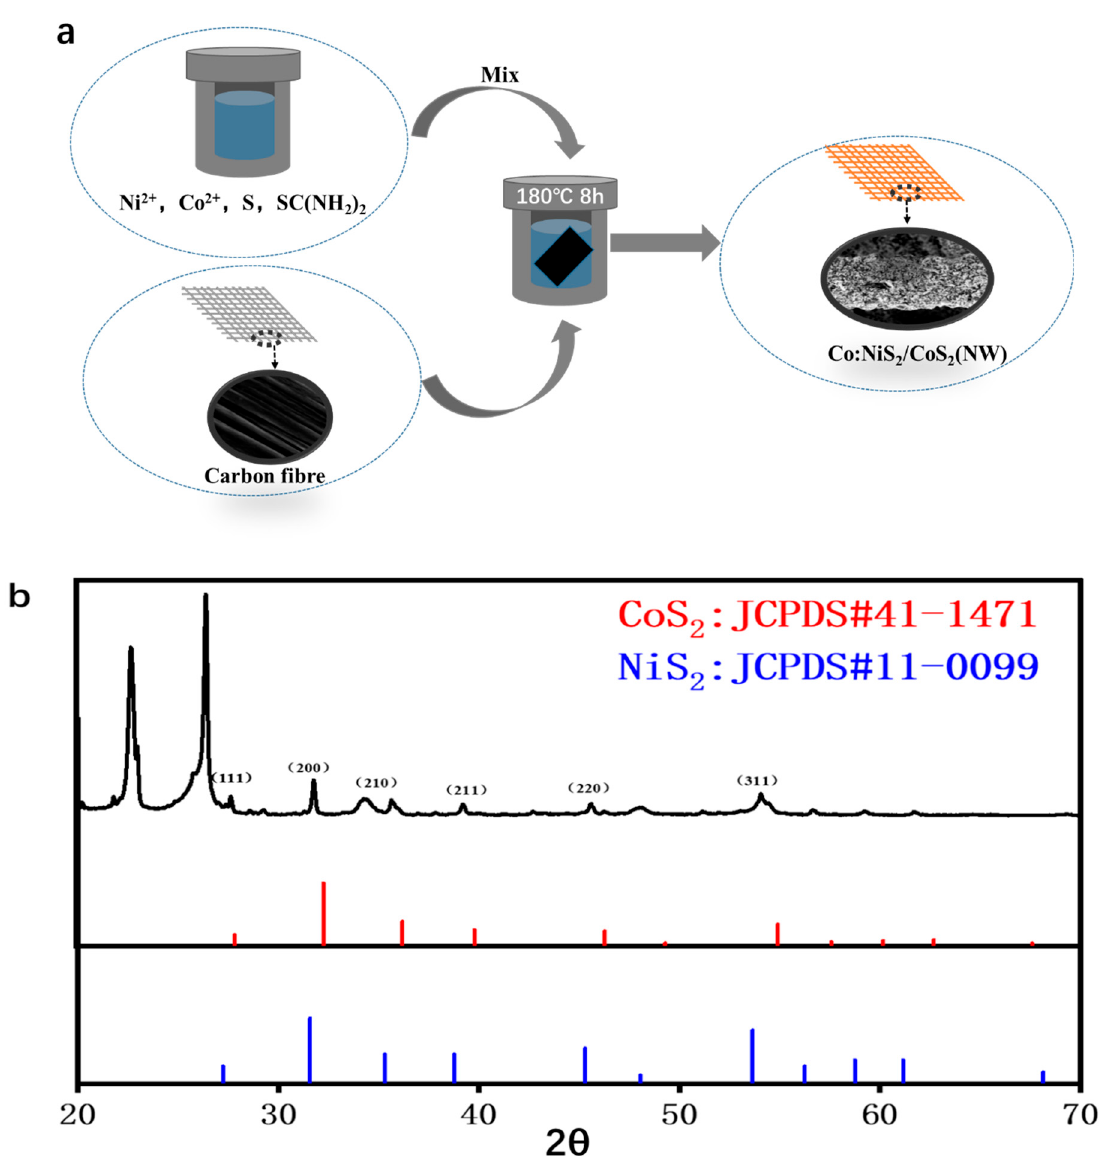
Figure 1. ( a ) Flow chart of hydrothermal preparation of Co-NiS 2 /CoS 2 heterostructures; ( b ) XRD pattern of Co-NiS 2 /CoS 2 heterostructures doped with 27% Co.